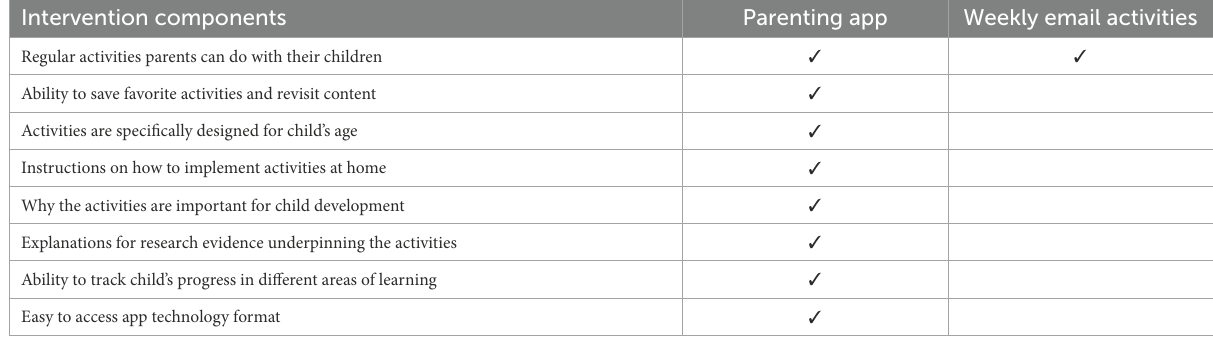
TABLE 2 Comparison of intervention components for the parenting app (Treatment group) and the weekly email activities (Active control group). Intervention